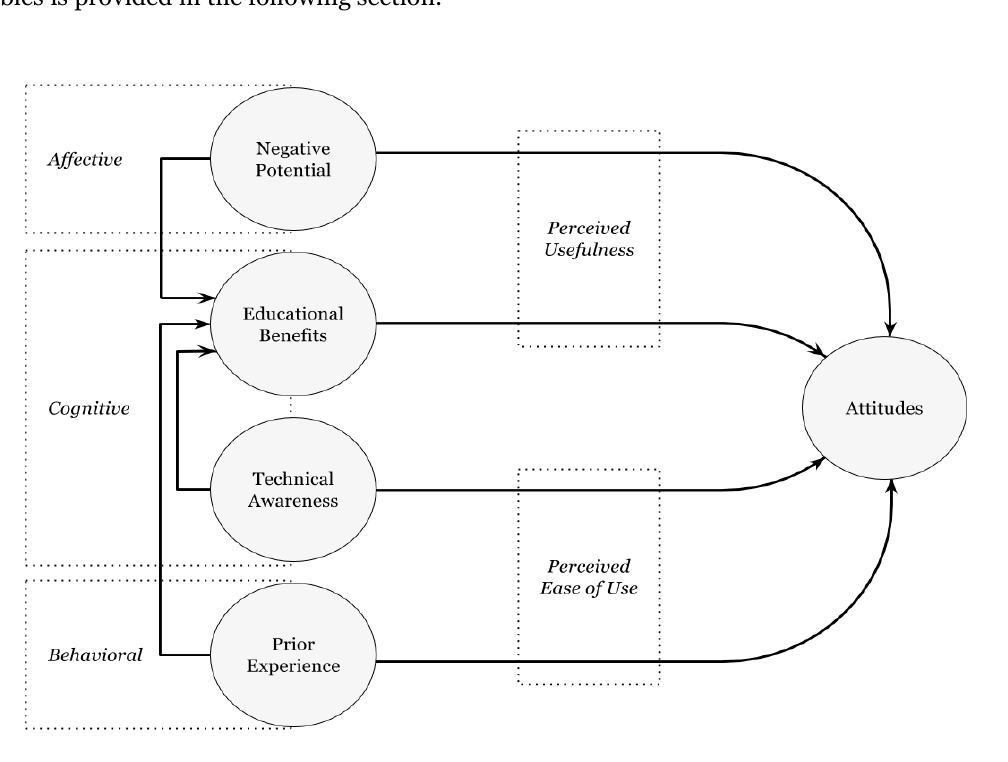
Figure 2. Proposed research model for attitudes toward tablet usage in